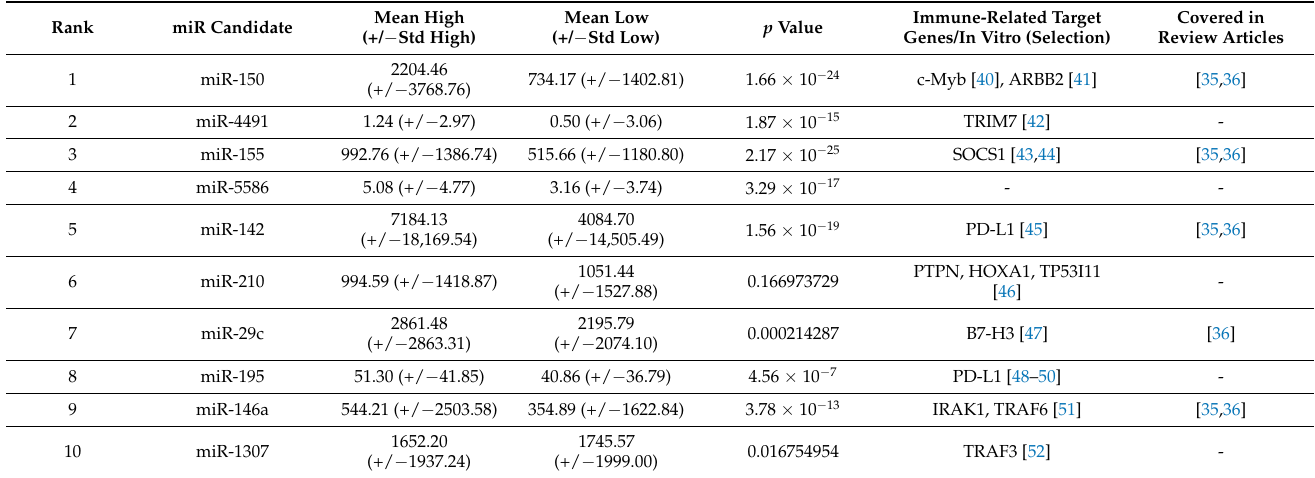
Table 1. MicroRNAs (miRs) predicted to best discriminate CXCR4 high- vs. low-expressing tumor samples. p values significant for p < 0.01 are highlighted in bold.